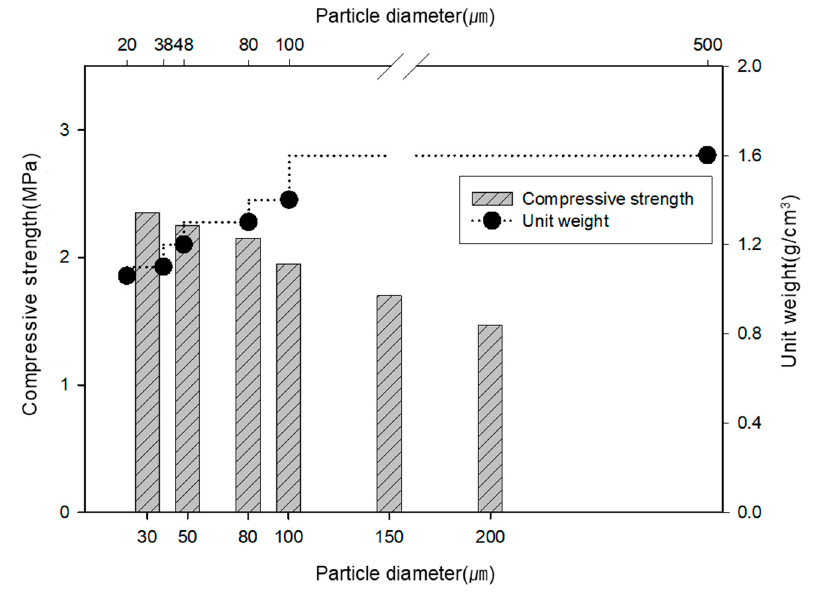
Figure 7. Relationship between the unit weight and compressive strength of feldspar according to the particle size.